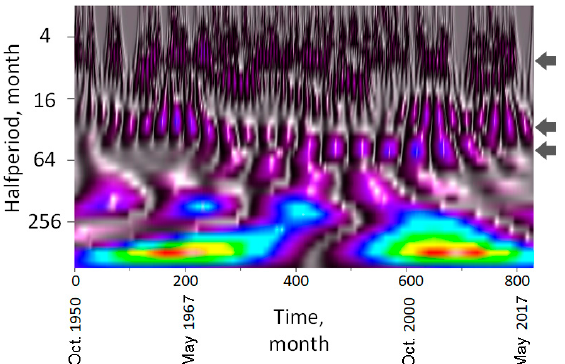
Figure 6. Wavelet-periodogram for GWT in the well # 5-5 (Khmilnyk, left bank of the Southern Bug) for 1950–2020. The horizontal axis represents the observation time in months; the vertical axis represents the half-period in months. The arrows show a series of spots, allowing us to reliably determine the cyclicity period: top arrow—1 year, middle arrow—5–6 years and lower arrow—8 years. The colors in the order of increasing intensity reflect the corresponding values of the wavelet transform coefficients.